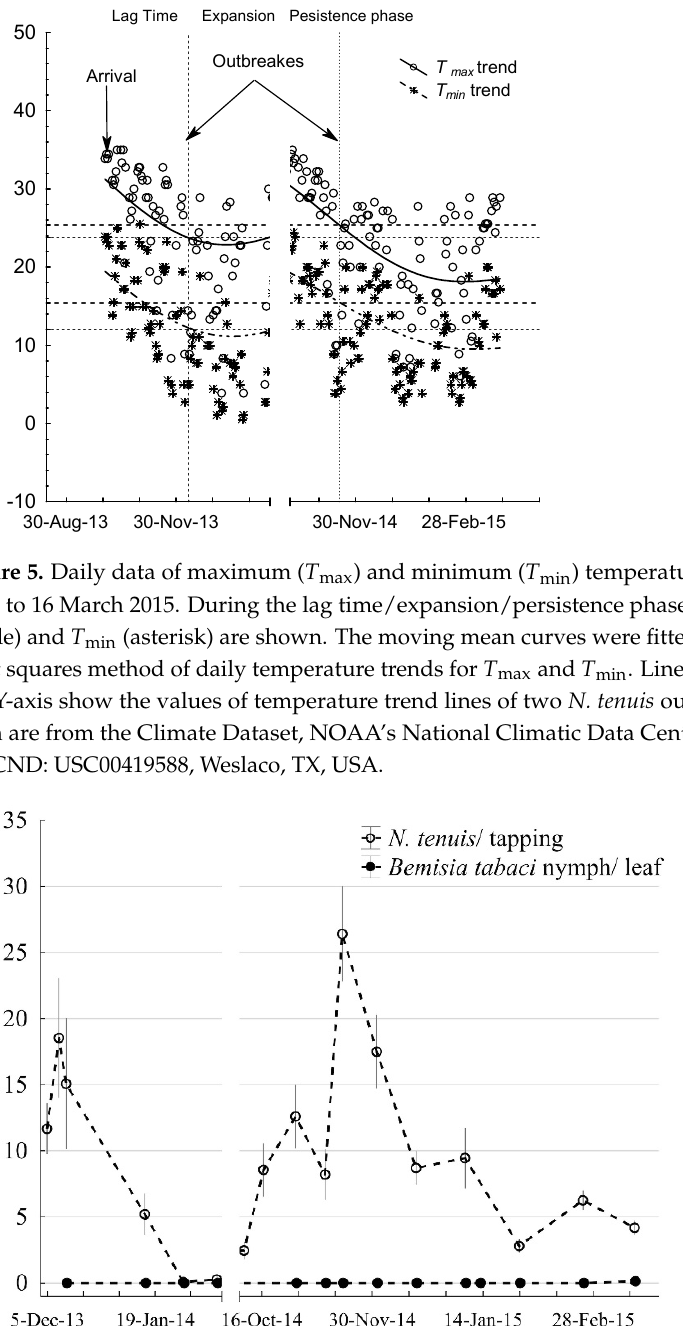
Figure 7. Effect of tomato cultivar and plastic color cover on N. tenuis population (mean ± SE): ( A ) Cultivar evaluation and ( B ) row mulch color evaluation. Means followed by different letters on a date are significantly different ( p ≤ 0.05, ANOVA and Fisher’s HSD). The moving mean curves shown with lines were fitted by a distance-weighted least squares method.